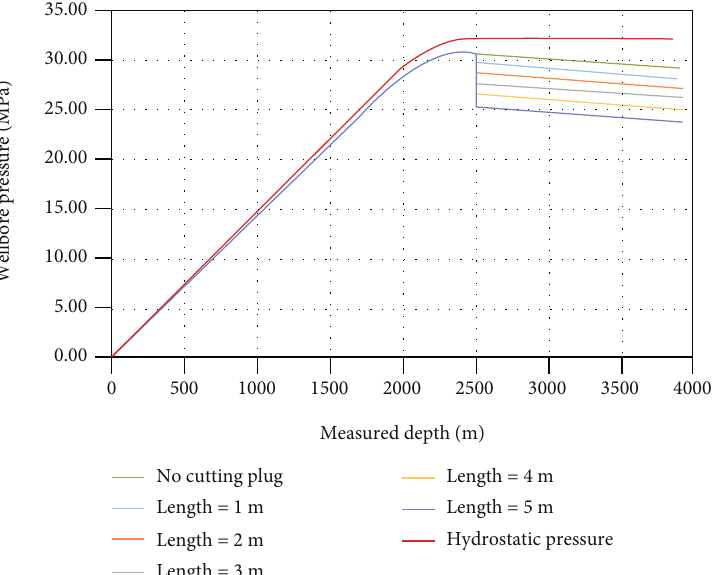
Figure 8: The e ff ect of cutting plug length on the wellbore pressures in a closed pipe